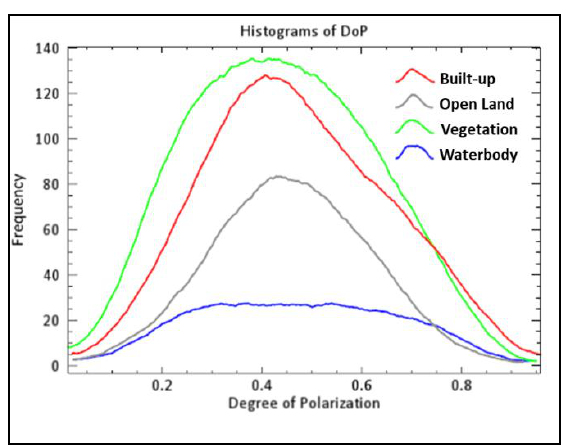
Figure 3: Histogram of DoP in different Land cover classes 4.1.3